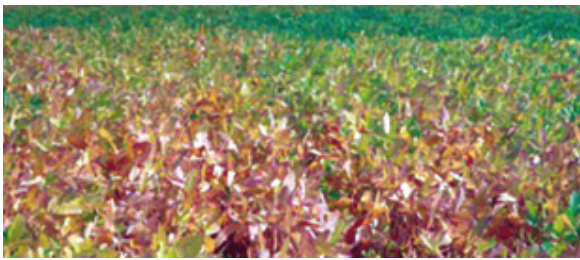
Figura 1. Sintomas observados em campo, na safra 2001/2002, em Botucatu (SP). Notam-se, no topo da figura, plantas verdes, sem sintomas.